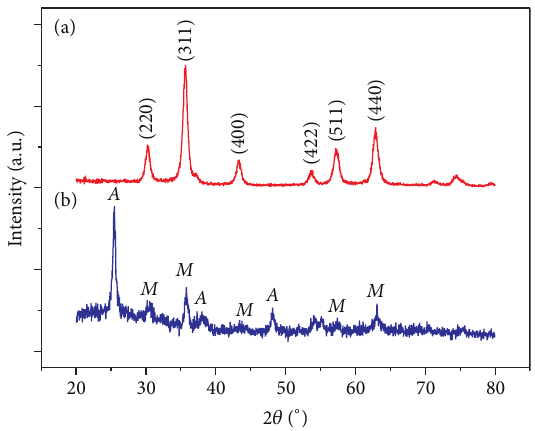
Figure 1: (a) XRD patterns of Fe 3 O 4 core and (b) TSF photocatalyst. 𝐴 : anatase and 𝑀 :